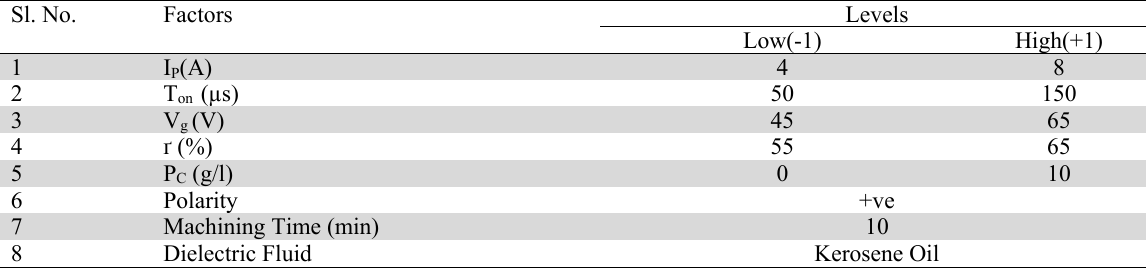
Level values of machining parameter Sl.